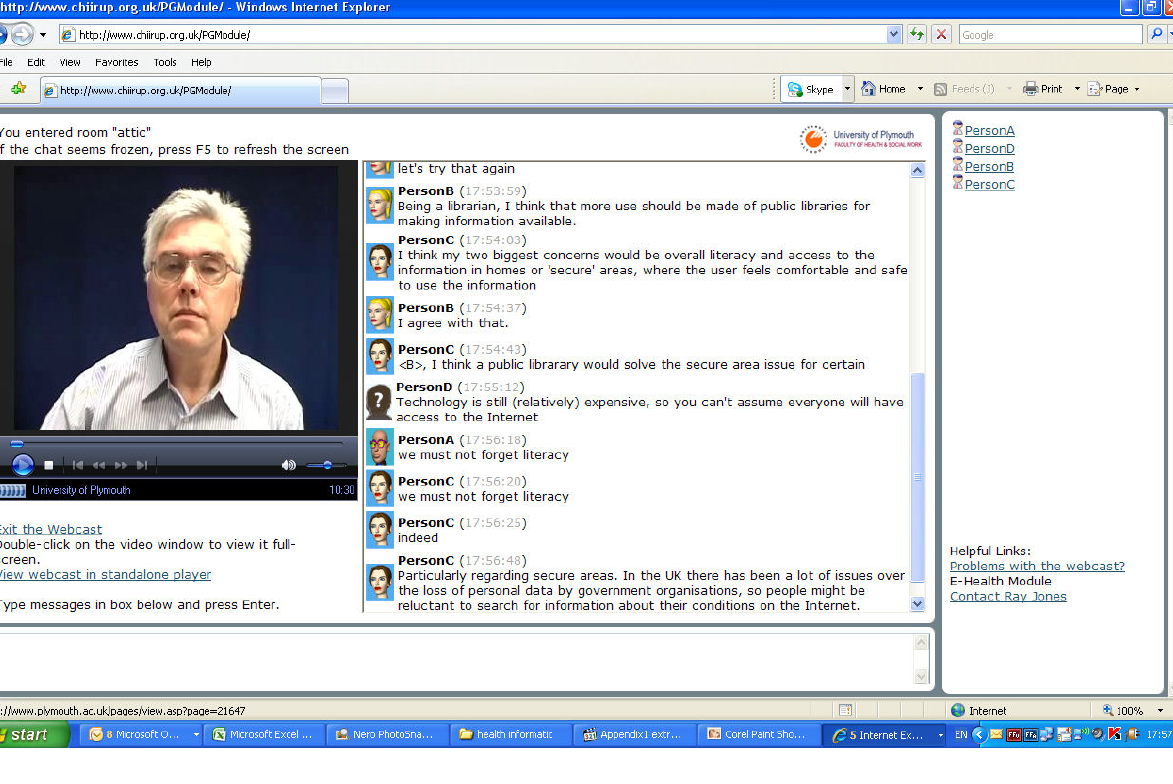
Table 1. Features of our webcasting CommentLive Interactive Webcasting